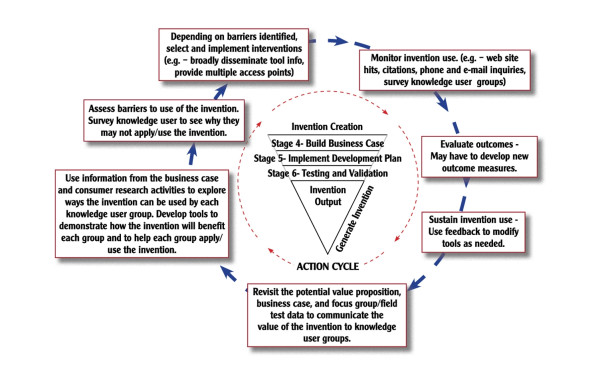
Invention Outputs.